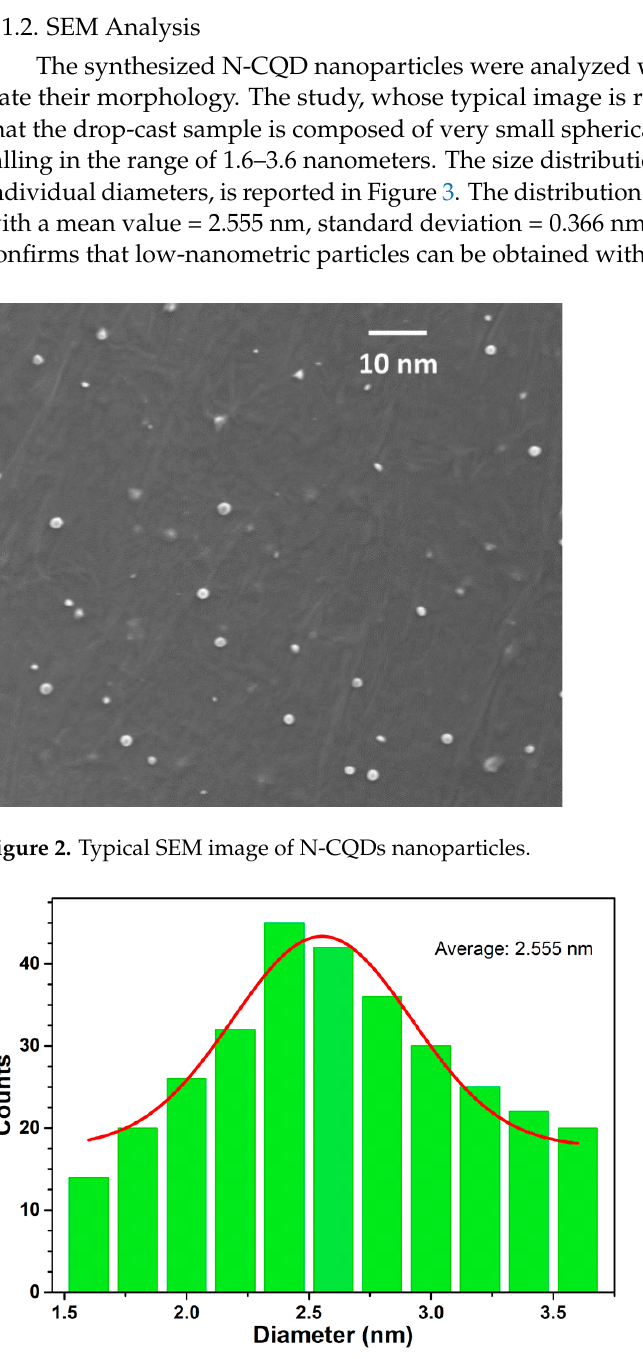
Table 2. EDX analyses of quantum dots. Atomic percentages of C, N and are averaged over three different areas for each of the two sample holders employed. Carbon